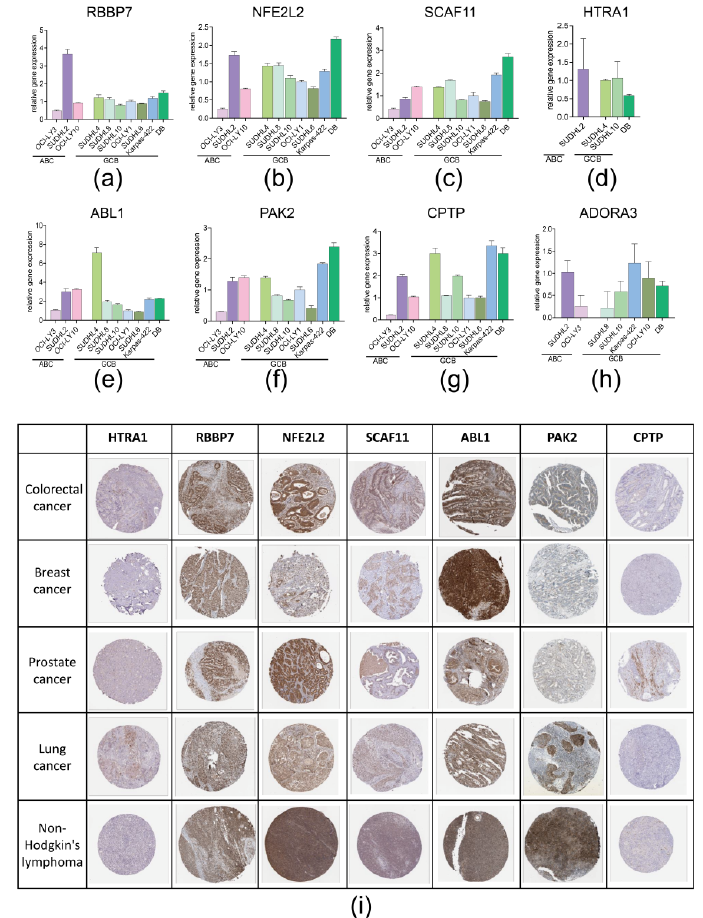
Figure 4. RT-qPCR and IHC slice image confirmed the expression of 8 PRGs in real world: ( a – h ) RT- PCR validation of 8 PRGs in vitro ABC and GCB cell lines; ( i ) IHC images of 7 PRGs in colorectal cancer, breast cancer, prostate cancer, lung cancer, and Non-Hodgkin’s Lymphoma. Beyond cell lines, we obtained the IHC slice images of HTRA1 , RBBP7 , NFE2L2 , SCAF11 , ABL1 , PAK2, and CPTP in colorectal cancer, breast cancer, prostate cancer, lung cancer, and Non-Hodgkin’s Lymphoma from The Human Protein Atlas (HPA)